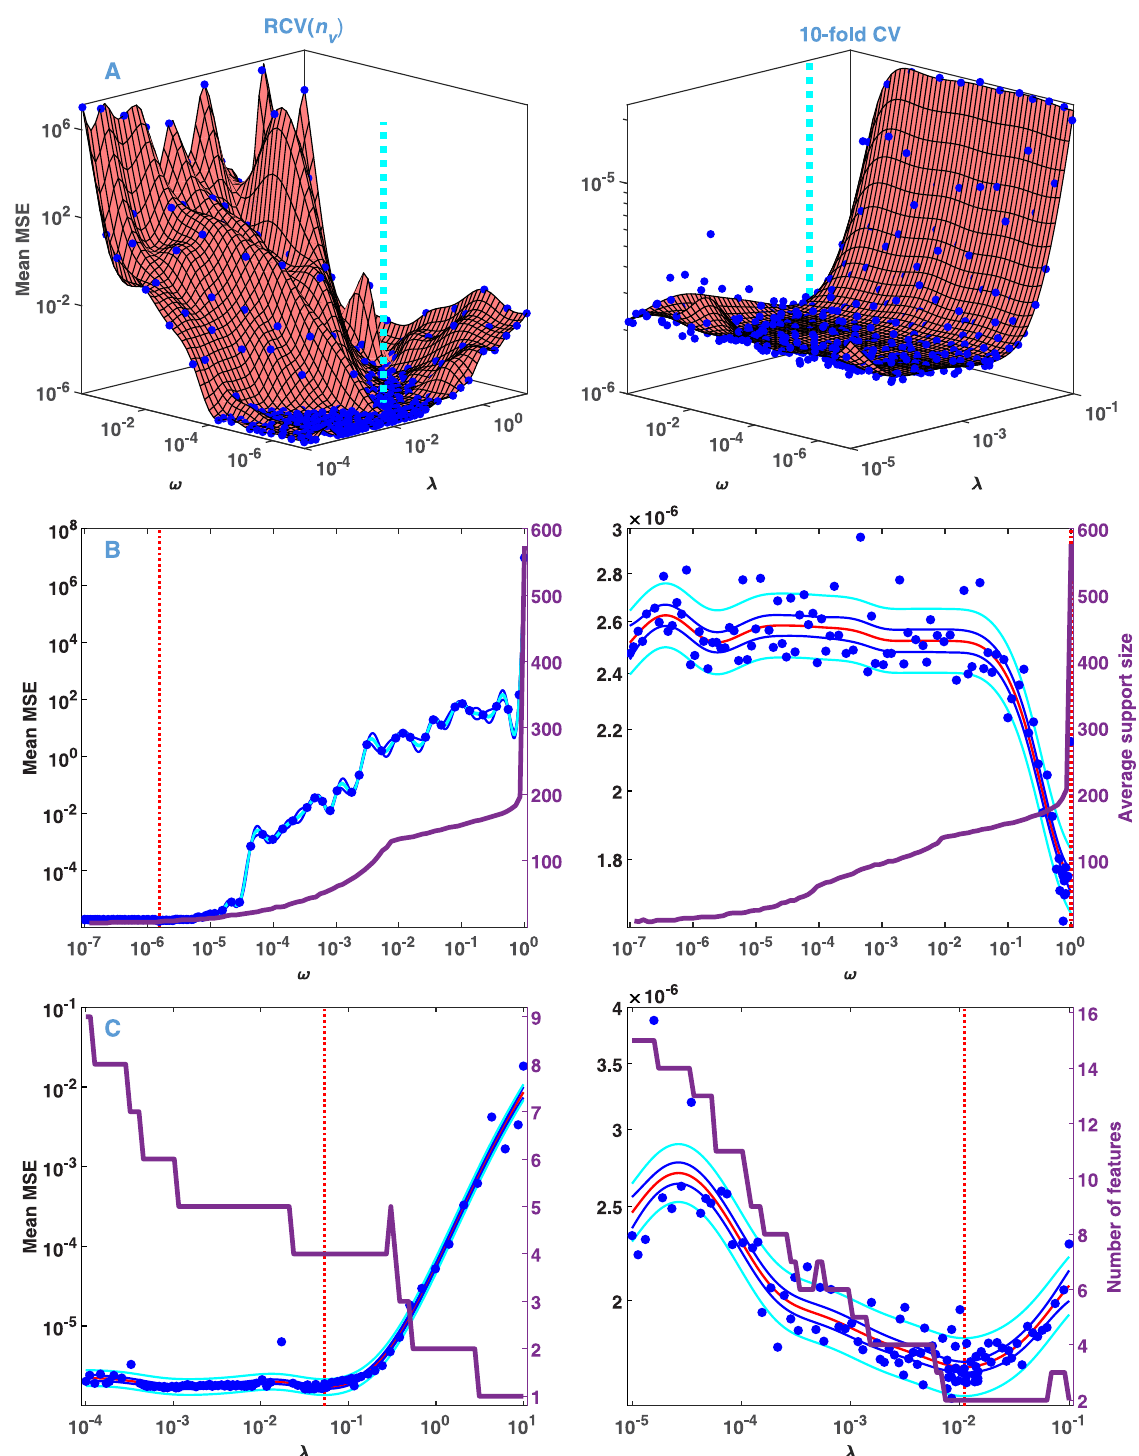
Fig 9. Model selection based on RCV(nv) and 10-fold CV from the distributed kinetic data presented in Fig 8. Noise level: σ rel = 10 − 3 . For details see the legends and caption of Fig 3.